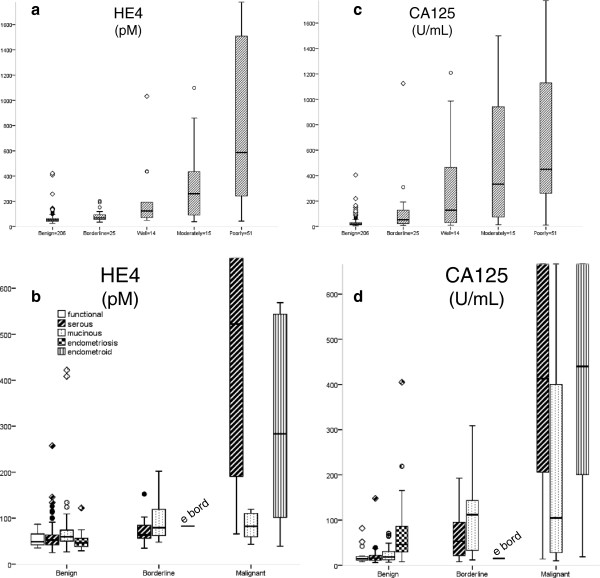
a-d Peripheral blood concentrations HE4 and CA 125 obtained preoperatively in patients with adnexal lesions. The boxes represent the 25th, 50th, 75th percentiles. Bars include highest and lowest values, except outliers (○), which are 1.5 to 3 box lengths from the end of the box, and extremes (◊) which are more than 3 box lengths from the end of the box.